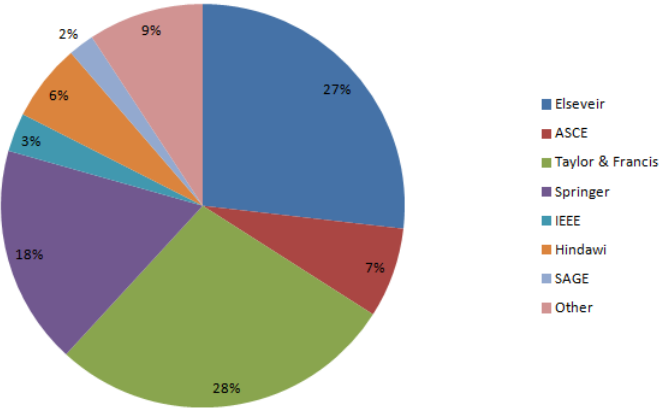
Figure 4. Chart of countries of the first author of the extracted research.